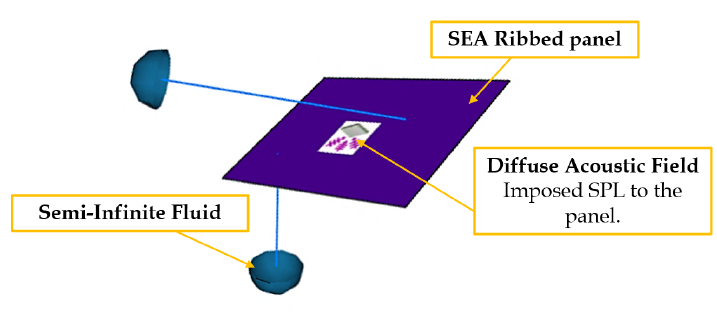
Figure 4. VAOne SEA Ribbed model (velocity computation).